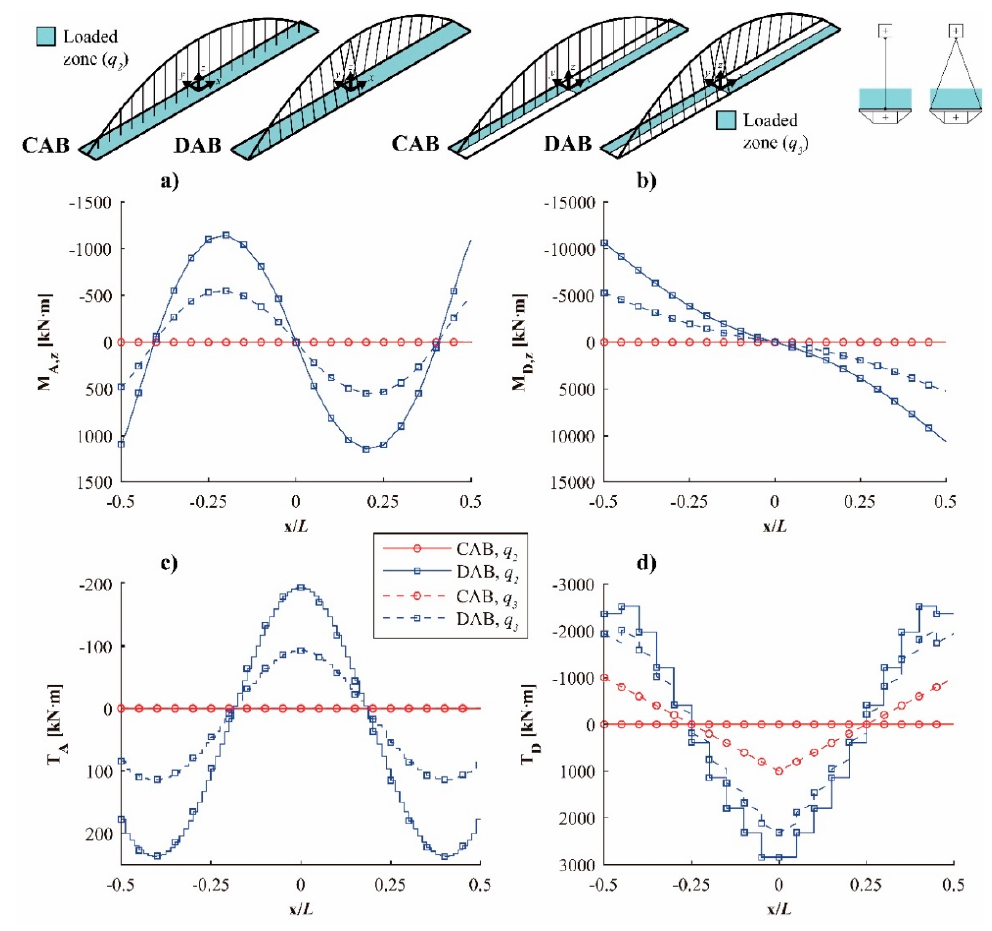
Figure 32. Out-of-plane bending moments at the arch ( a ) and the deck ( b ) under q 2 and q 3 . Torsion at the arch ( c ) and the deck ( d ) under q 2 and q 3 for the CAB and DAB.